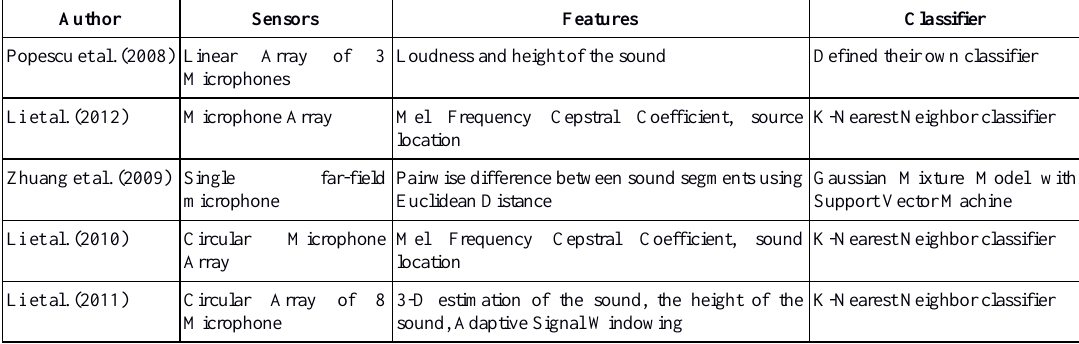
Table 3. Acoustic-based fall detection